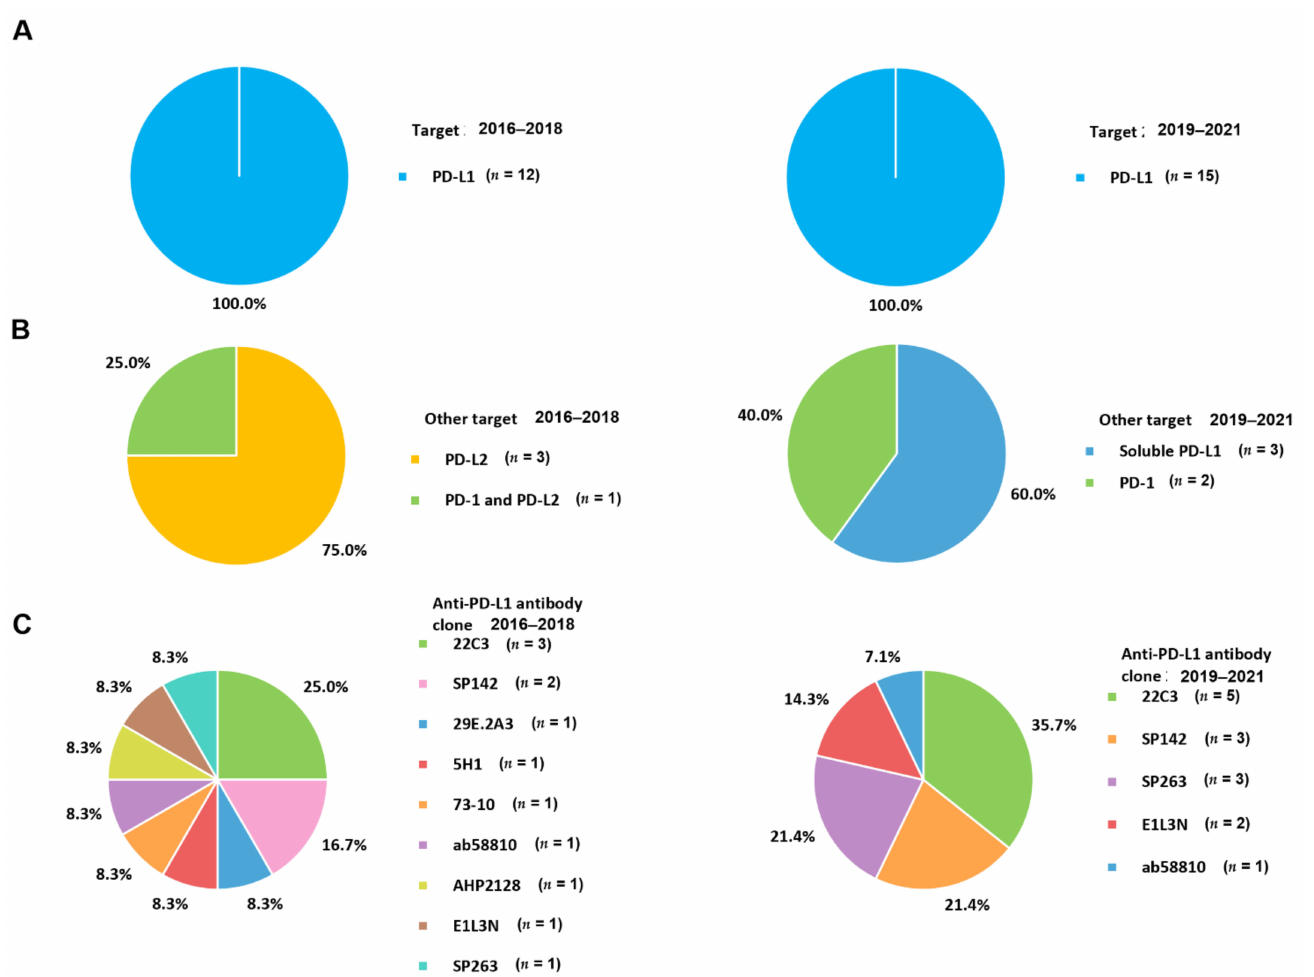
Figure 7. Changes in the targets for PD-1 according to the epoch. ( A ) Pie charts showing the consistent target of PD-L1; ( B ) pie charts presenting the changes of other targets concurrently used with PD-L1; and ( C ) pie charts showing the changes of antibody clones of PD-L1. PD-1, programmed cell death protein-1; PD-L1, programmed death ligand-1; PD-L2, programmed death